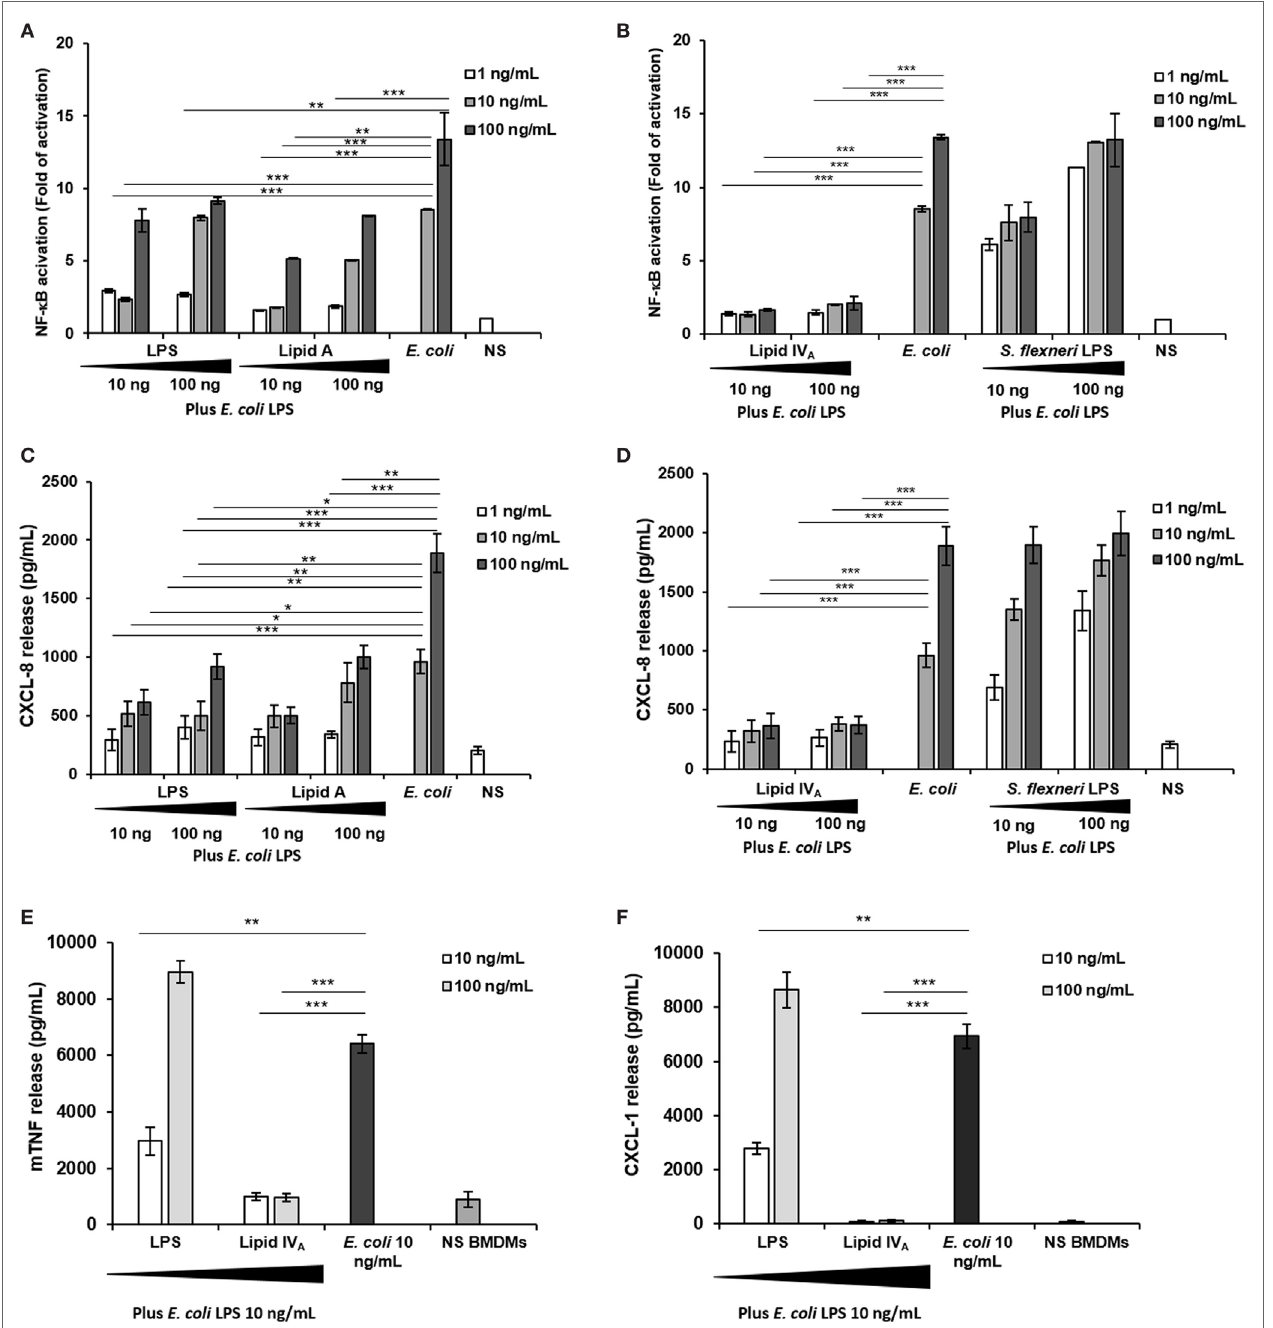
FigUre 4 | Competition assay: (a–D) HEK293 hTLR4 cell line; (e,F) BMDMs. (a,B) Fold of nuclear factor kappa B activation and (c,D) CXCL-8 release following priming with 10 and 100 ng/mL of Bradyrhizobium LPS or lipid A, or with lipid IV A or with Shigella flexneri hexa-acylated LPS for 1 h and then exposed to Escherichia coli LPS (10 and 100 ng/mL) for 4 h. Stimulation with the only E. coli LPS (10 and 100 ng/mL) for 5 h was used as a control. (e,F) BMDMs were stimulated with 10 and 100 ng/mL of Bradyrhizobium LPS or with lipid IV A during 1 h and then incubated with 10 ng/mL of E. coli LPS for 4 h. After this time TNF and CXCL-1 release were quantified. Stimulation with the only E. coli LPS (10 ng/mL) for 5 h was used as a control. Data are expressed as mean ± SD of three independent experiments in triplicate. * p < 0.05, ** p < 0.01, and *** p < 0.001, after Student’s t